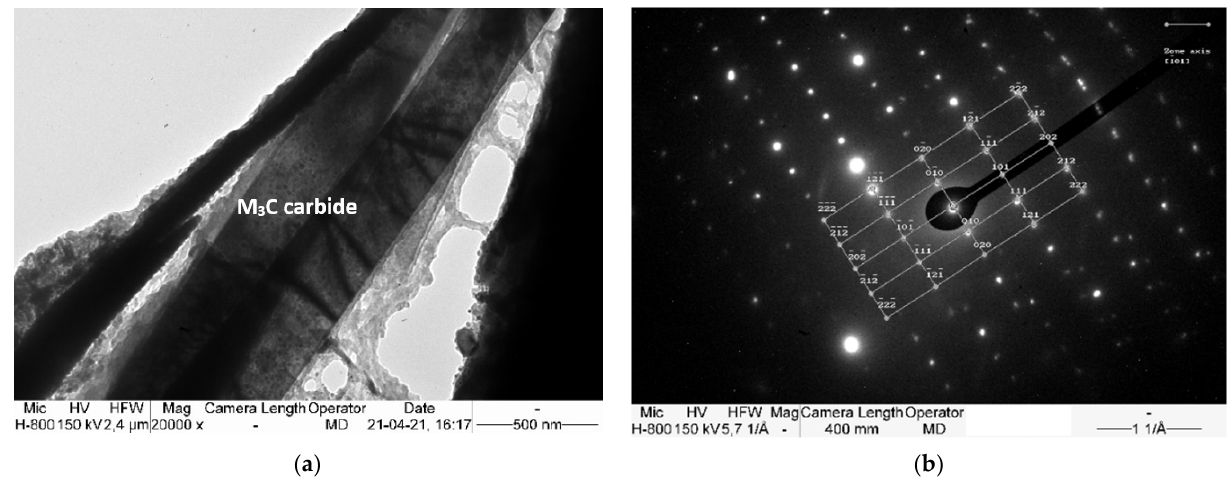
Figure 6. ( a ) Thin M 3 C carbide plates in the austenite matrix. ( b ) Diffraction pattern obtained from (Fe,Mn) 3 C carbide with zone axis [101] showed in ( a ). TEM.